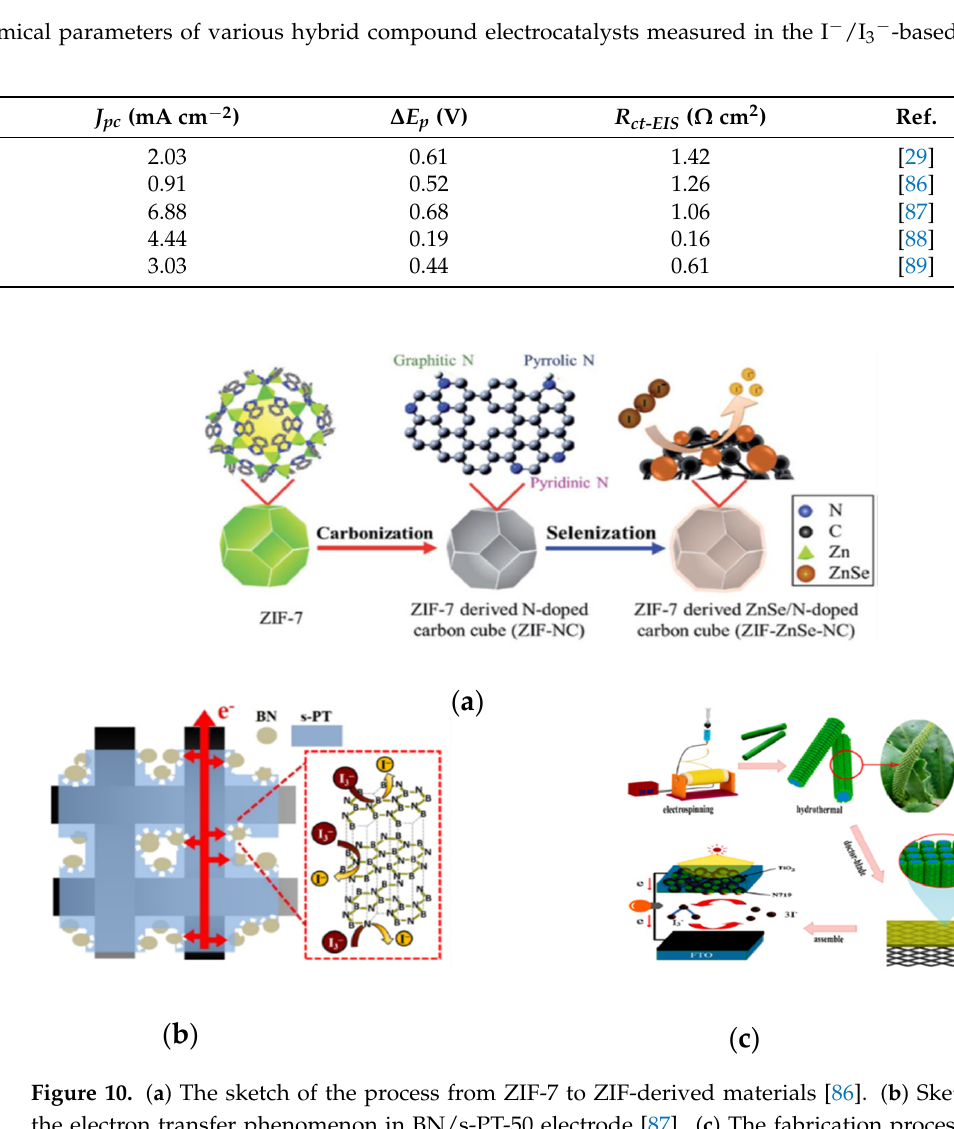
Figure 11. SEM images of ( a ) ZIF-ZnSe-NC-11 wt% [86], ( b ) BN/s-PT-50 [87], and ( c ) Bi 2 MoO6/CNFs [89]. ( d ) The TEM image of Bi 2 MoO 6 /CNFs [89].